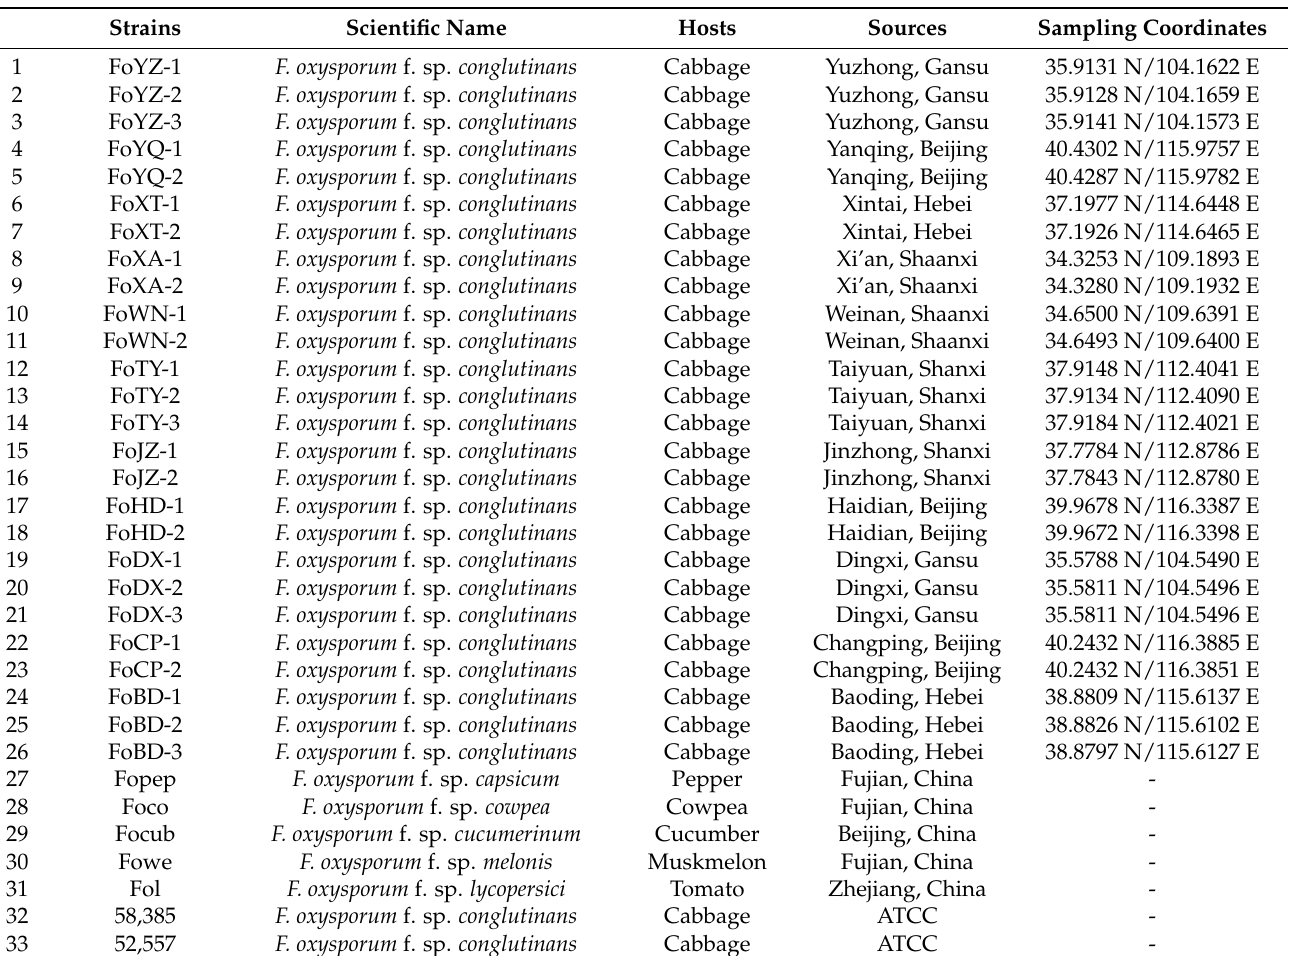
Table 1. FOC1 isolates and other FO used in this study.